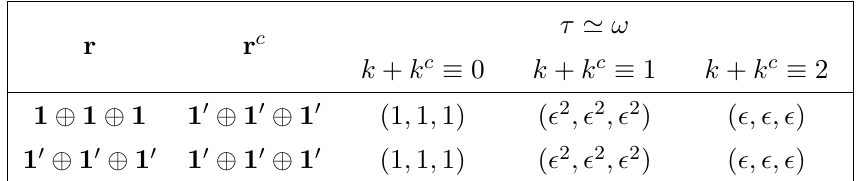
Table 10. Leading-order mass spectra patterns of bilinears ψ c ψ in the vicinity of the symmetric point ω , for 3d multiplets ψ ∼ ( r , k ) and ψ c ∼ ( r c , k c ) of the finite modular group Γ 0 are insensitive to transposition, i.e. to the exchange ψ ↔ ψ c . Congruence relations for k + k c are modulo